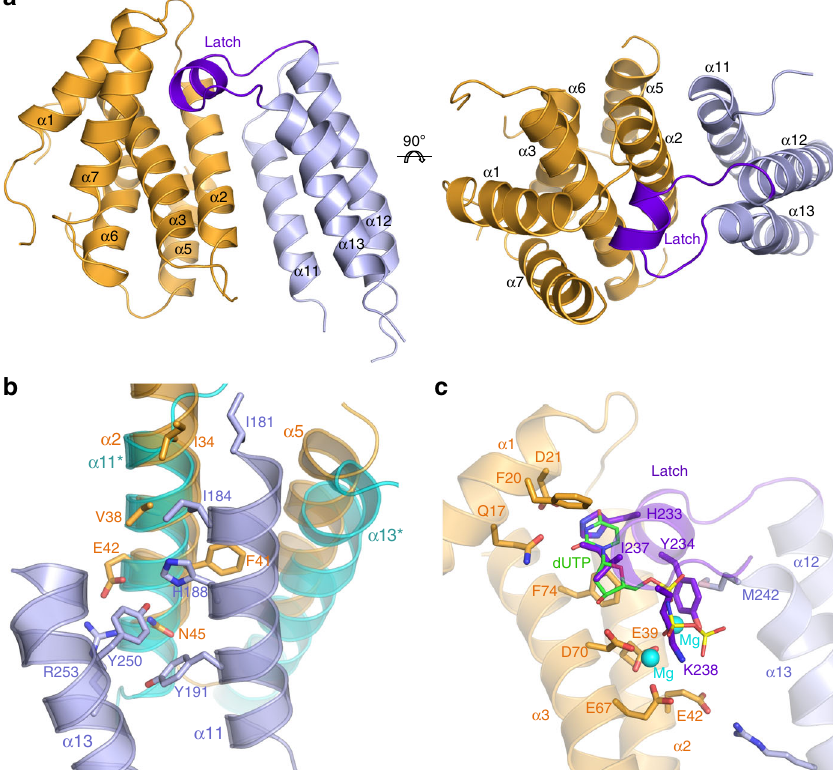
Fig. 5 Crystal structure of the BovI-Stl C-ter – Dut ϕ O11 complex. a Cartoon representation of BovI-Stl C-ter in complex with the dimeric Dut from phage ϕ O11. Dut ϕ O11 is coloured in orange and BovI-Stl C-ter in blue, with the “ latch ” that projects over the Dut active centre highlighted in purple. Structural elements from both proteins are labelled. Two orthogonal views are shown. b Partner mimicry by Stl. Detailed view of the BovI-Stl C-ter – Dut ϕ O11 heterodimerization helices coloured as a superimposed on the BovI-Stl C-ter homodimer showing the dimerization helices from the second BovI-Stl C-ter protomer in cyan. The interacting residues in the BovI-Stl C-ter – Dut ϕ O11 complex are shown in sticks and coloured by atom type with the carbon atoms in the identical colour of the corresponding molecule. Structural elements are labelled. c Stl latch mimics interactions of the dUTP substrate with Dut ϕ O11. Detailed view of the BovI- Stl C-ter projecting its latch onto the Dut ϕ O11 active centre, coloured as in a . Dut ϕ O11 residues involved in substrate dUTP-Mg recognition and binding, which also mediate interactions with BovI-Stl C-ter , are shown in sticks and labelled, as are their BovI-Stl C-ter counterparts. The substrate dUTP-Mg was placed in the active centre of Dut ϕ O11 in complex with BovI-Stl C-ter by superimposing the structure of Dut ϕ O11-dUTP (PDB 5MIL 4 ) and is shown in sticks with carbon atoms in green. The Mg ions chelated by the dUTP are shown as a cyan spheres. The interacting structural elements of Dut ϕ O11 and BovI-Stl C-ter are represented in semi-transparent cartoon. The omit electron density map is shown in Supplementary Fig.